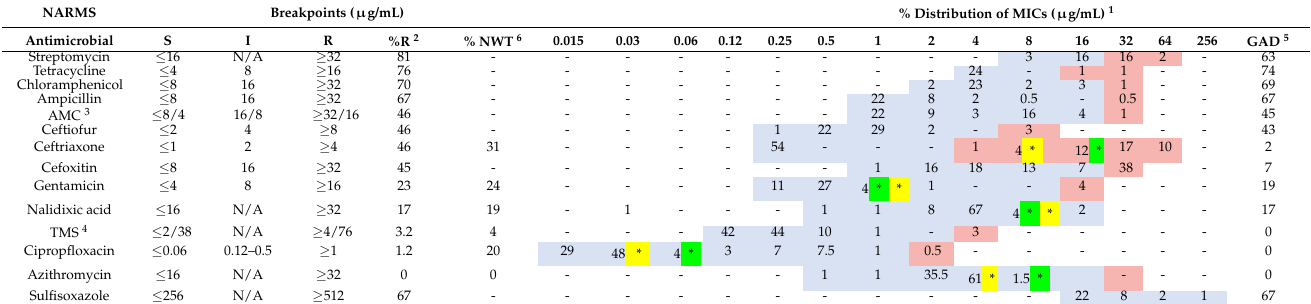
1 Distribution of the percentage of isolates with minimum inhibitory concentration (MIC). 2 Percent of isolates classified as resistant to the referred antimicrobial drug . 3 Amoxicillin clavulanic acid; only the nominator for the fractions for this drug combination are referred to in the MIC table. 4 Trimethoprim sulfamethoxazole; only the nominator for the fractions for this drug combination are referred to in the MIC table. 5 Percent of isolates with growth in all dilutions tested for the referred drug, indicating an MIC greater than the highest concentration tested. 6 Percentage of isolates classified as non-WT using ECOFFs with 99% endpoint criteria. N/A indicates no intermediate breakpoint available for referenced